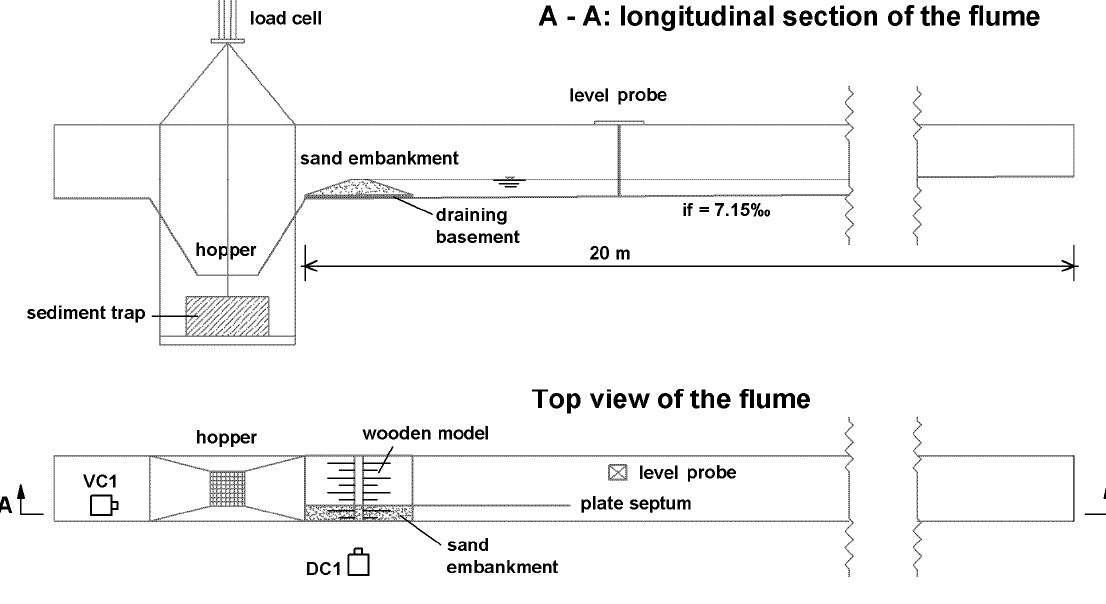
Fig. 4. Sketch of the flume in the experiment. Water flows from right to left.